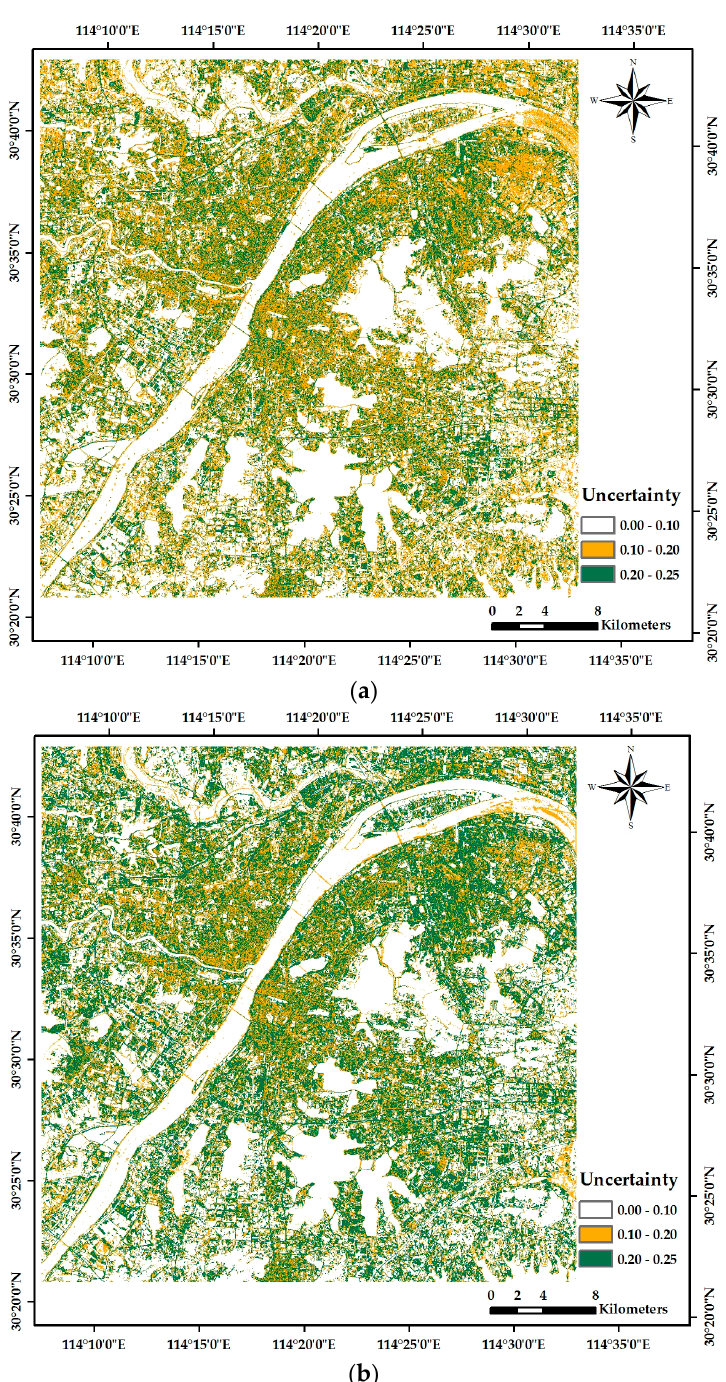
Figure 12. The spatial distributions of the uncertainty levels for the fused impervious surfaces. ( a ) The uncertainty values of impervious surfaces derived by fusing the GF-1 and Sentinel-1A images; ( b ) The uncertainty values of impervious surfaces derived by fusing the GF-1 and Sentinel-1A images and their features.